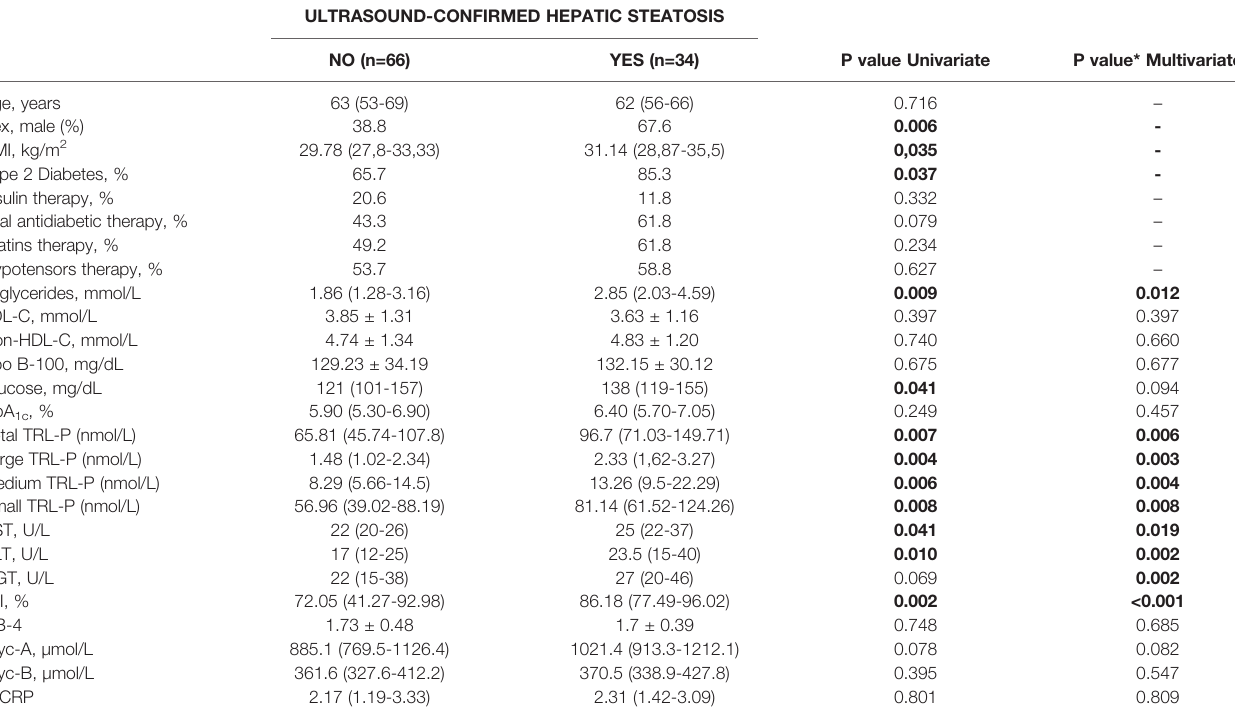
TABLE 3 | Clinical and biochemical parameters of 100 ultrasound-studied patients sorted by the presence (YES) or absence (NO) of hepatic steatosis. ULTRASOUND-CONFIRMED HEPATIC